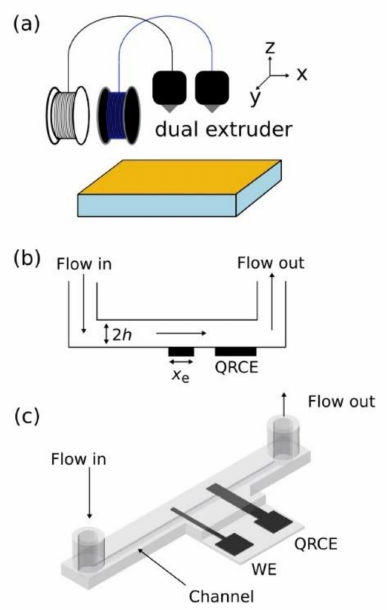
Figure 15. Schematic of the experimental setup and devices. ( a ) Schematic of dual-extrusion 3D printing setup with two materials, ( b ) schematic representation of the channel flow geometry and the positions of the two electrodes. This schematic is not to scale. ( c ) CAD drawing of a channel flow cell with a 1.5 mm × 1.0 mm channel and two band electrodes (Reproduced with permission from Reference [152], copyright 2019,